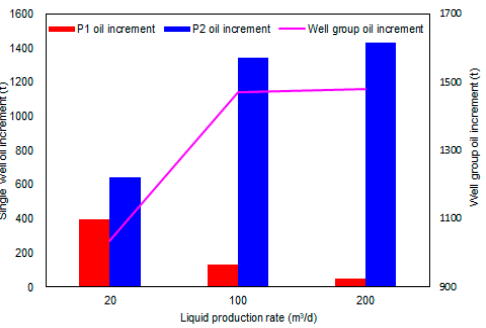
Figure 27. Influence of fluid production rate on the oil increase in well P2.